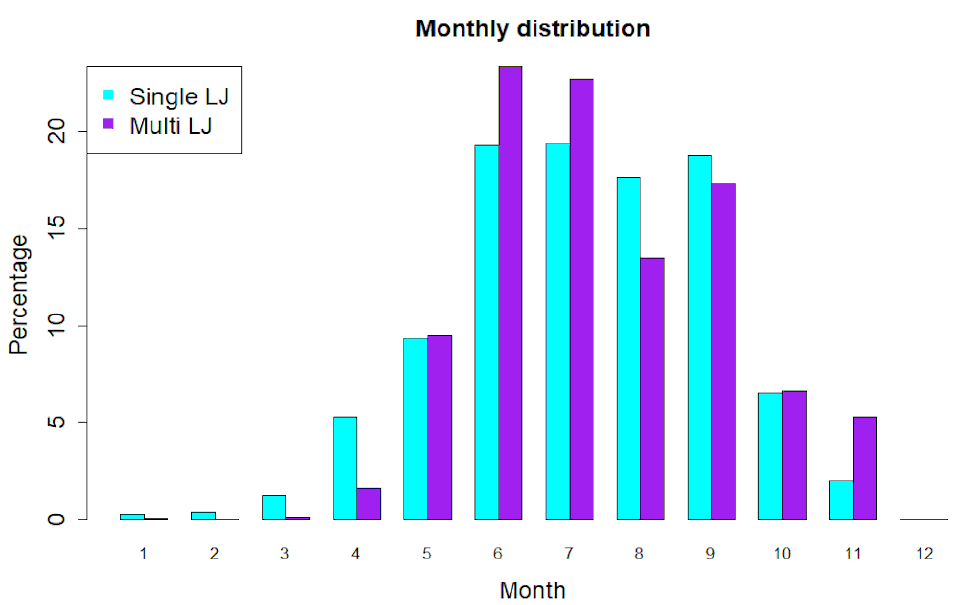
Figure 7. Monthly distributions (in percentage) of the SLJsts (cyan) and MLJsts (purple). The hourly distributions (Figure 8) also presented the same pattern, with the maximum probability of occurrence between 12 UTC and 18 UTC (coinciding with the diurnal cycle of the convection). However, the peak of the SLJsts was sharper because their duration was shorter and more concentrated in less hours. On the other hand, the MLJsts can stand for longer periods, and then, LJs can also occur out of the maximum